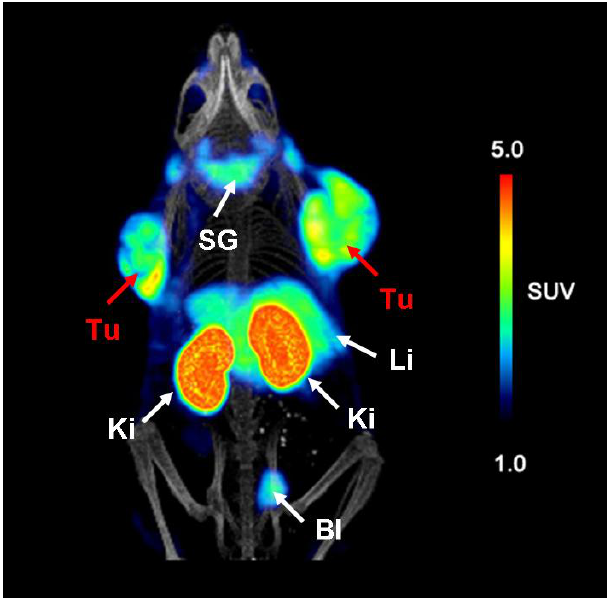
Figure 7. ( a ) PET/CT image of a tumor bearing mouse 2 h after injection of